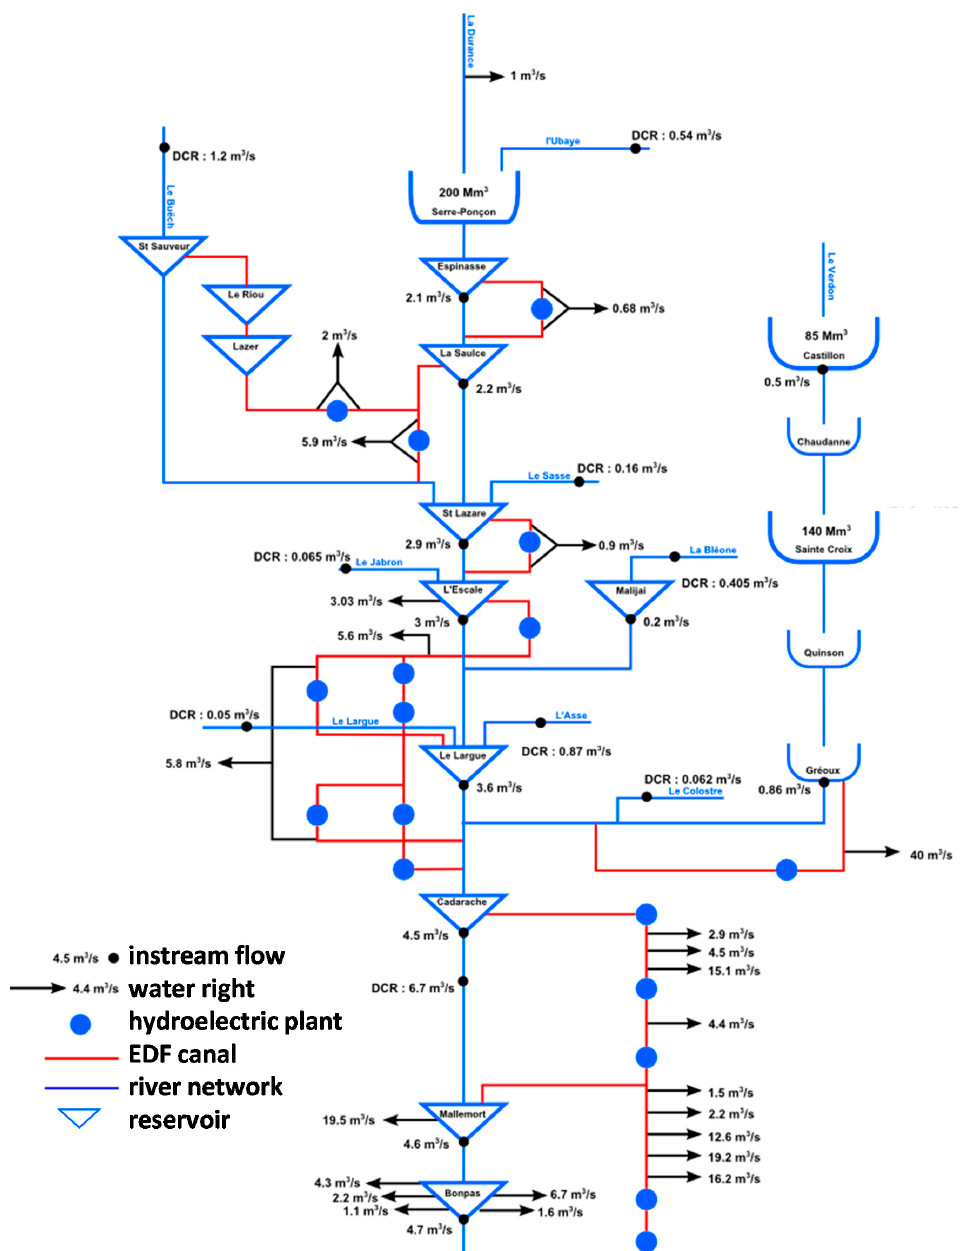
Figure 2. Simplified representation of the Durance and Verdon Valleys (data source: EDF, Actéon).